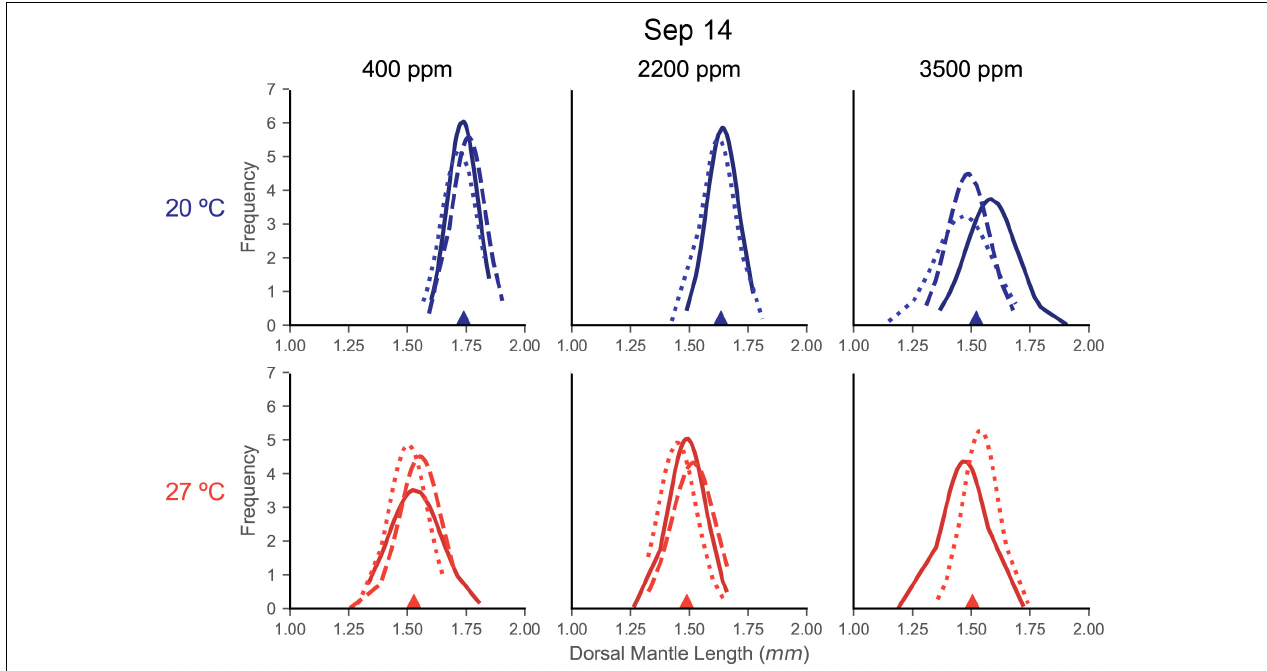
FIGURE 3 | Fitted normal distributions of DML histogram density from individual egg capsules in each treatment of the September 14 trial. Histograms are not shown for clarity of curves, but DML data were segmented in 0.05 mm bins. Each plot is a treatment combination, with column determining acidification (titles) and row determining temperature treatment (also differentiated by color: top/blue = 20 ◦ C, bottom/red = 27 ◦ C). Each line represents the curve from the sampling of an individual egg capsule for DML ( x -axis). Lines are shaded and patterned to help differentiate individual egg capsules within a plot, but this carries no relationship or meaning across the plots. The filled triangle on the x -axis marks the mean value for the compiled sample of that treatment.